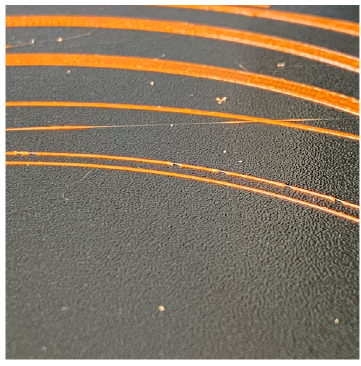
Figure 9. Inconsistent extrusion of filament.